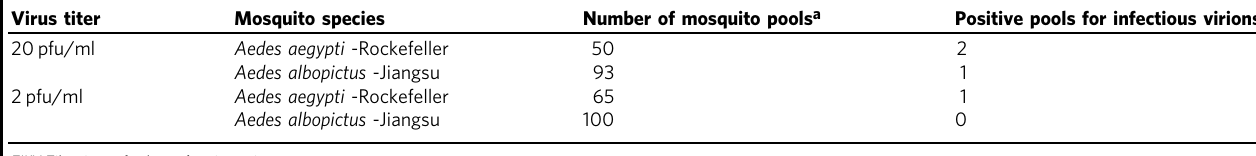
Table 1 Measurement of infectious ZIKV particles in mosquitoes breeding in ZIKV urine Virus titer Mosquito species Number of mosquito pools a Positive pools for infectious virions 20 pfu/ml Aedes aegypti -Rockefeller